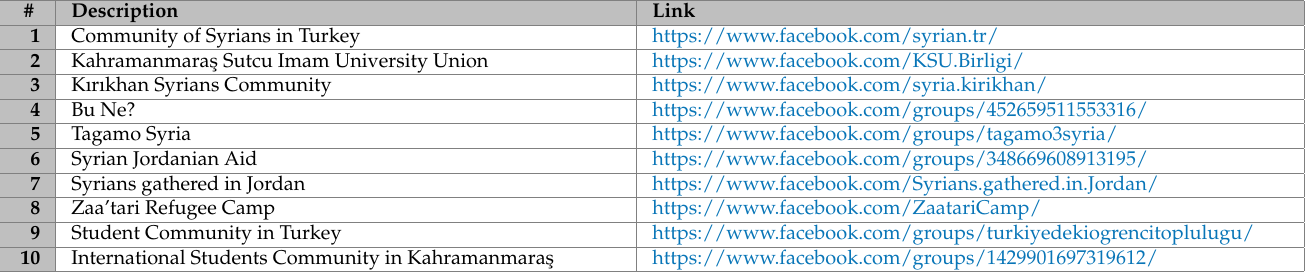
Table 1. Facebook Groups to which the Questionnaire Link was Circulated.